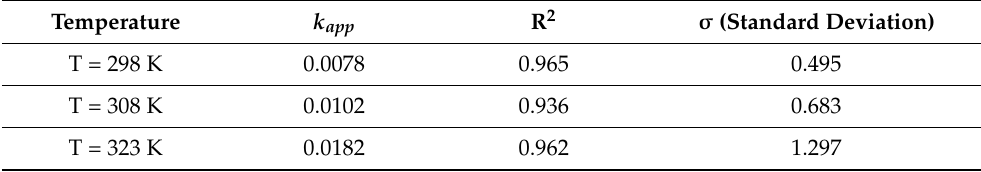
Table 2. The coefficient of determination R 2 and apparent rate constants k app